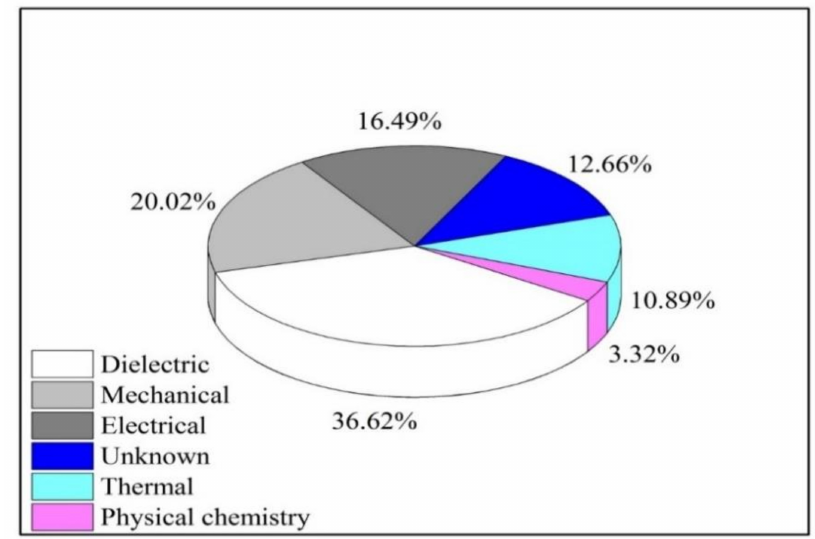
Figure 2. Main causes of high voltage (HV) equipment (especially transformer) collapse [29] with permission from